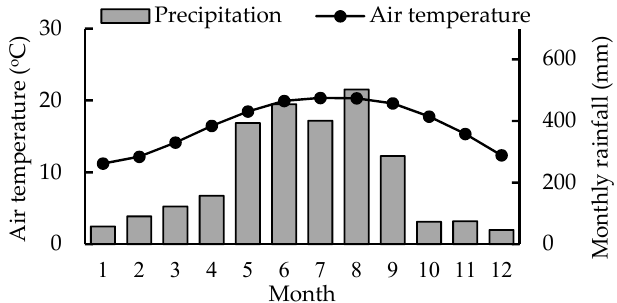
Figure 1. Long-term monthly average air temperatures and monthly rainfall at the Xitou agricultural meteorological station (1941–2012).